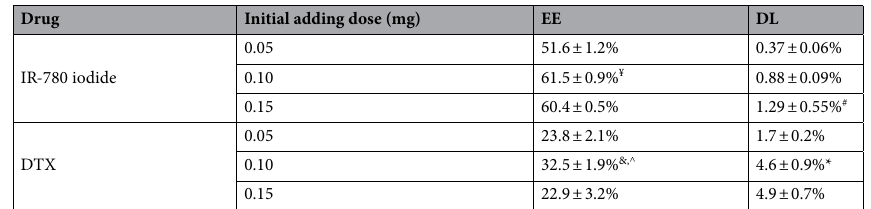
Table 1. The EE and DL of IR-780 iodide and DTX in IR780-NBs-DTX with different initial doses. # P < 0.05, significantly different from the DL of IR-780 iodide with an initial dose of 0.05 mg. ¥ P < 0.05, significantly different from the EE of IR-780 iodide with an initial dose of 0.05 mg. *P < 0.05, significantly different from the DL of DTX with an initial dose of 0.5 mg. & P < 0.05, significantly different from the EE of DTX with an initial dose of 0.5 mg. ^ P < 0.05, significantly different from the EE of DTX with an initial dose of 1.5 mg. Data are presented as the mean ± standard deviation.